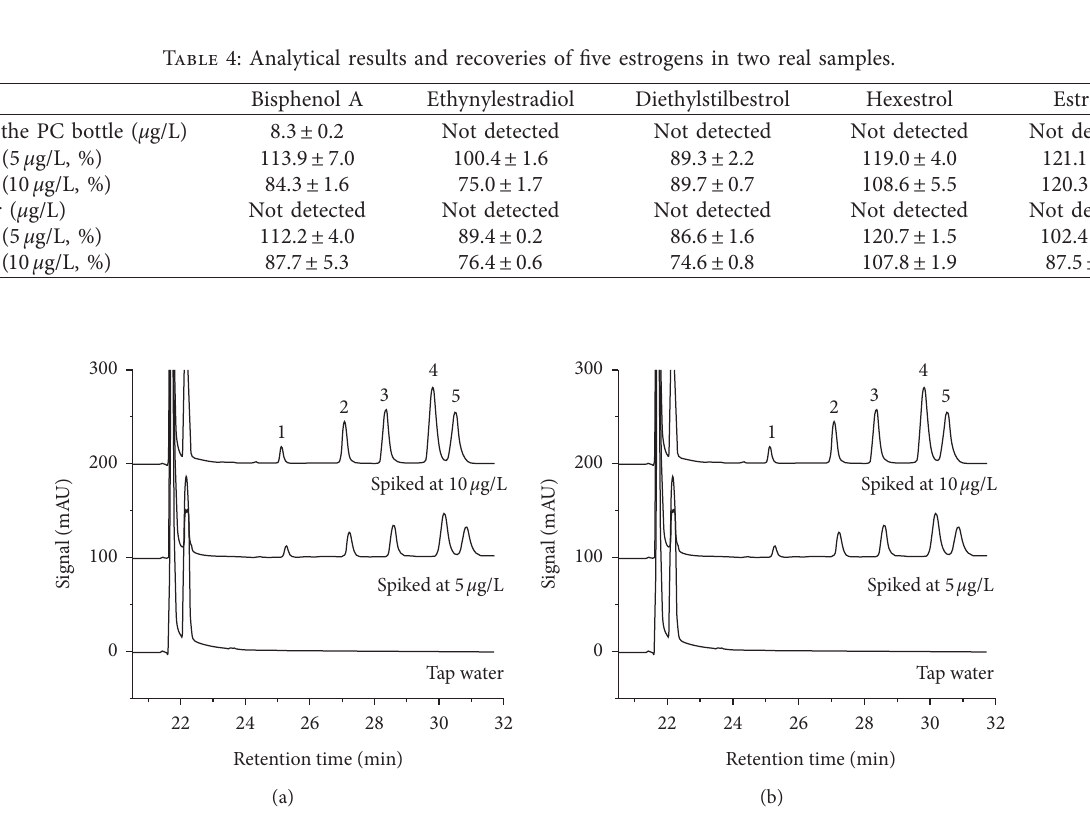
Figure 8: HPLC chromatograms of (a) samples for water in the PC bottle, spiked at 5 μ g/L and 10 μ g/L, (b) samples for tap water, spiked at 5 μ g/L and 10 μ g/L. Peaks: (1) bisphenol A (2) ethynylestradiol, (3) diethylstilbestrol, (4) hexestrol, and (5) estrone. Other conditions are the same as in Figure